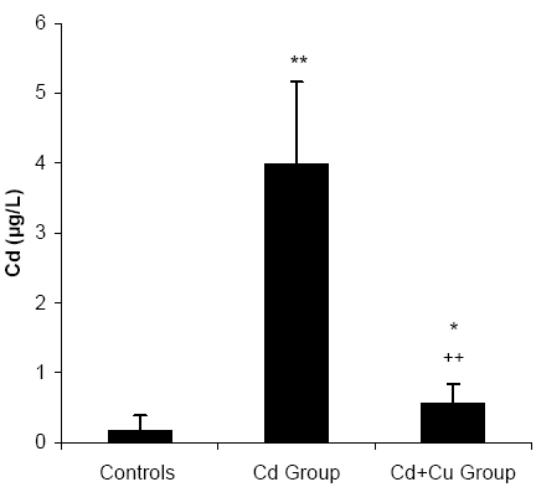
Fig. 1 Maternal Cd levels. *P < 0.05, ** P < 0.01 between controls and Cd or Cd+Cu groups. ++P < 0.01 between Cd and Cd+Cu groups.